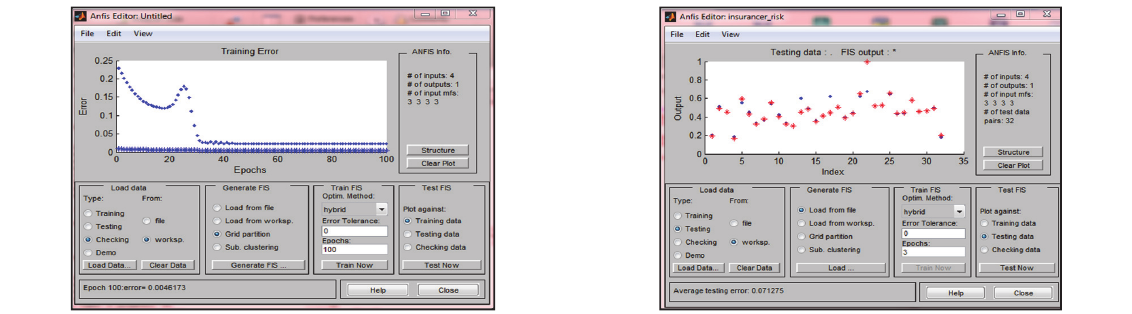
Fig. 3. A View of Neural Network Training and Valida- tion Process in MATLAB